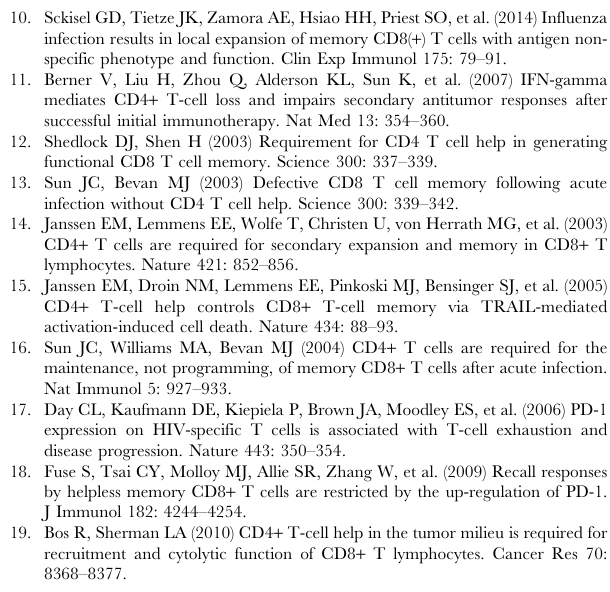
Figure S2 IT induced immunologic effects in the long term CD4 depletion model. Control or long term CD4 depleted C57BL/6 mice were treated with IT or PBS/rIgG (control) and effects on CD8 + T cell expansion, PD-1 expression, and function were quantified by flow cytometric analysis. NKG2D and granzyme B expression were quantified by flow cytometric analysis. Interferon gamma production was quantified by flow cytometric analysis after in vitro restimulation of splenocytes with